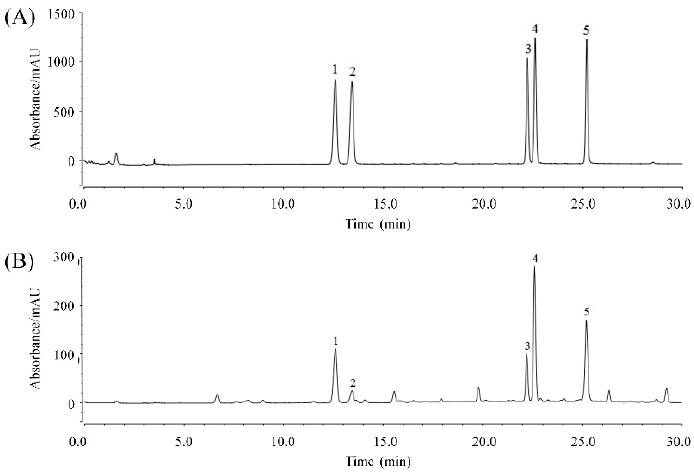
Table 1. Determination of KTP constituents by HPLC (one sample).